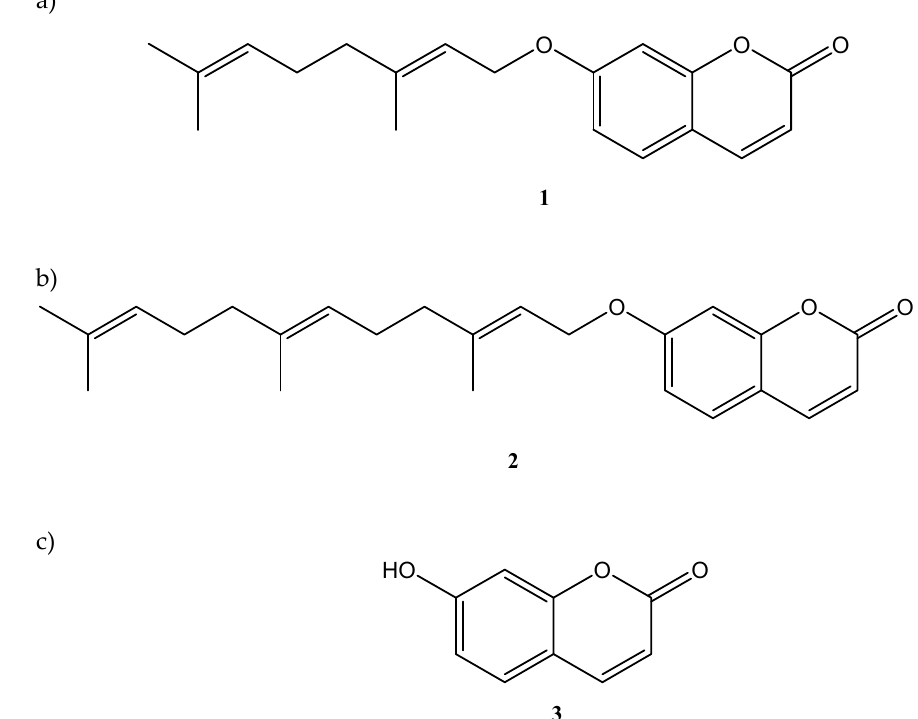
Figure 1. Chemical structures of ( a ) auraptene 1 , ( b ) umbelliprenin 2 , and ( c ) umbelliferone 3 .